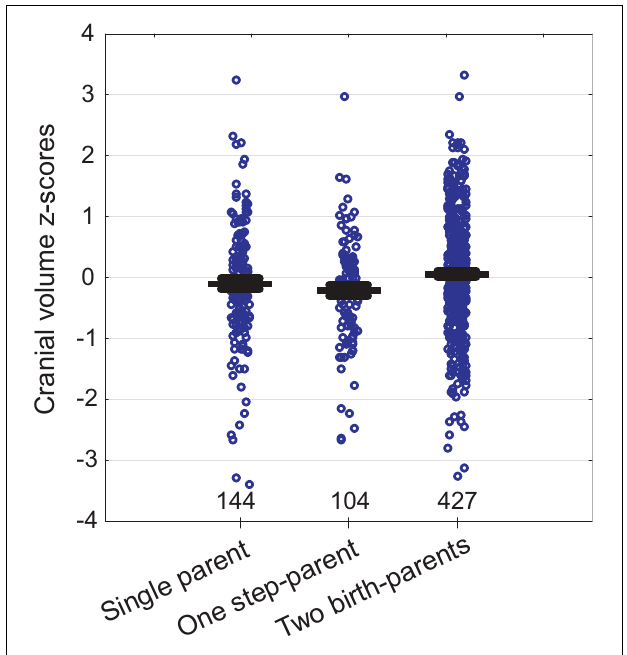
FIGURE 2 | Cranial volume of children in relation to family type. Whiskers denote standard errors. Sample sizes at